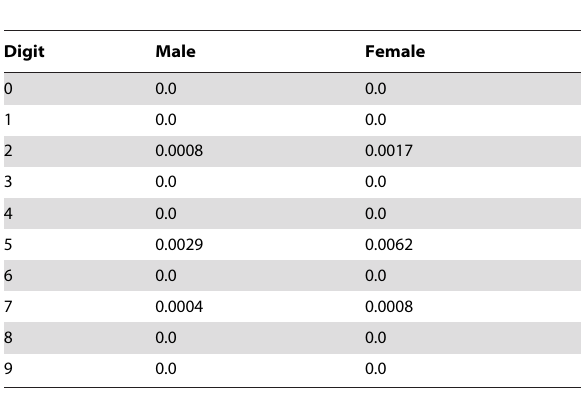
Table 1. Test set error fractions of individual detector